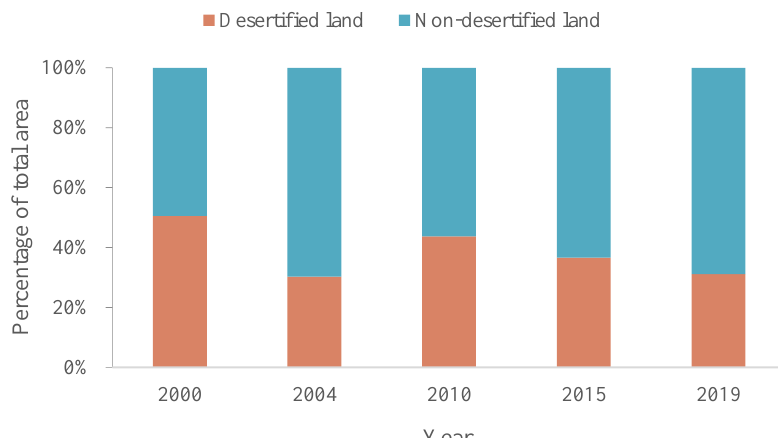
Figure 8. Proportion of ADL in the total area of the Zhenglan Banner.